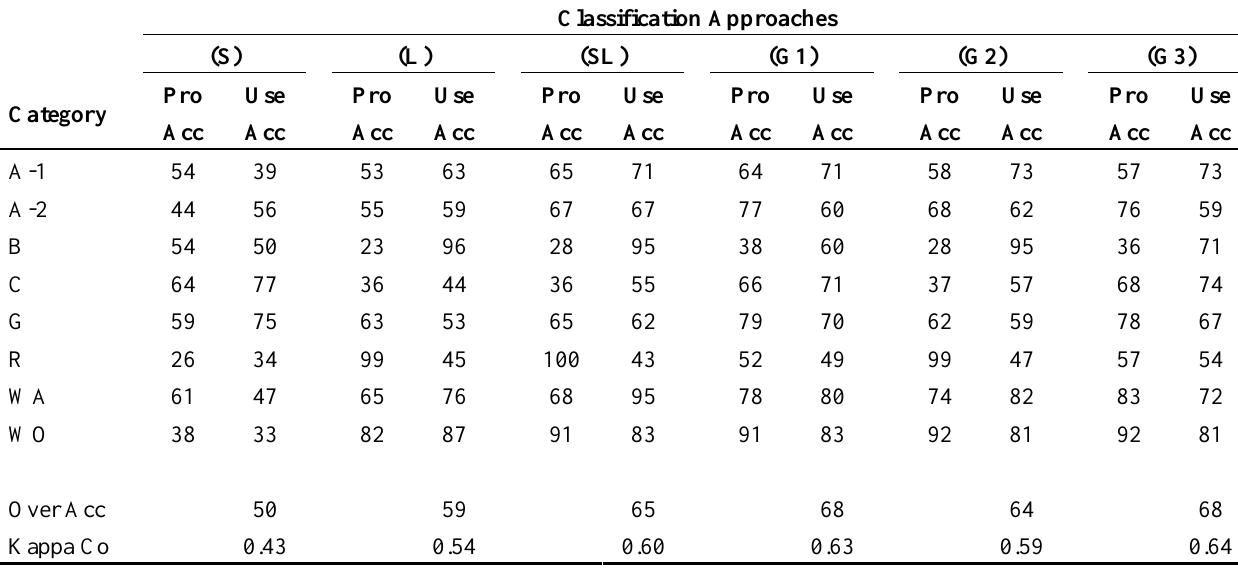
Table 5. Classification accuracy produced by the (S), (L), (SL), (G1), (G2), and (G3) approaches. Classification